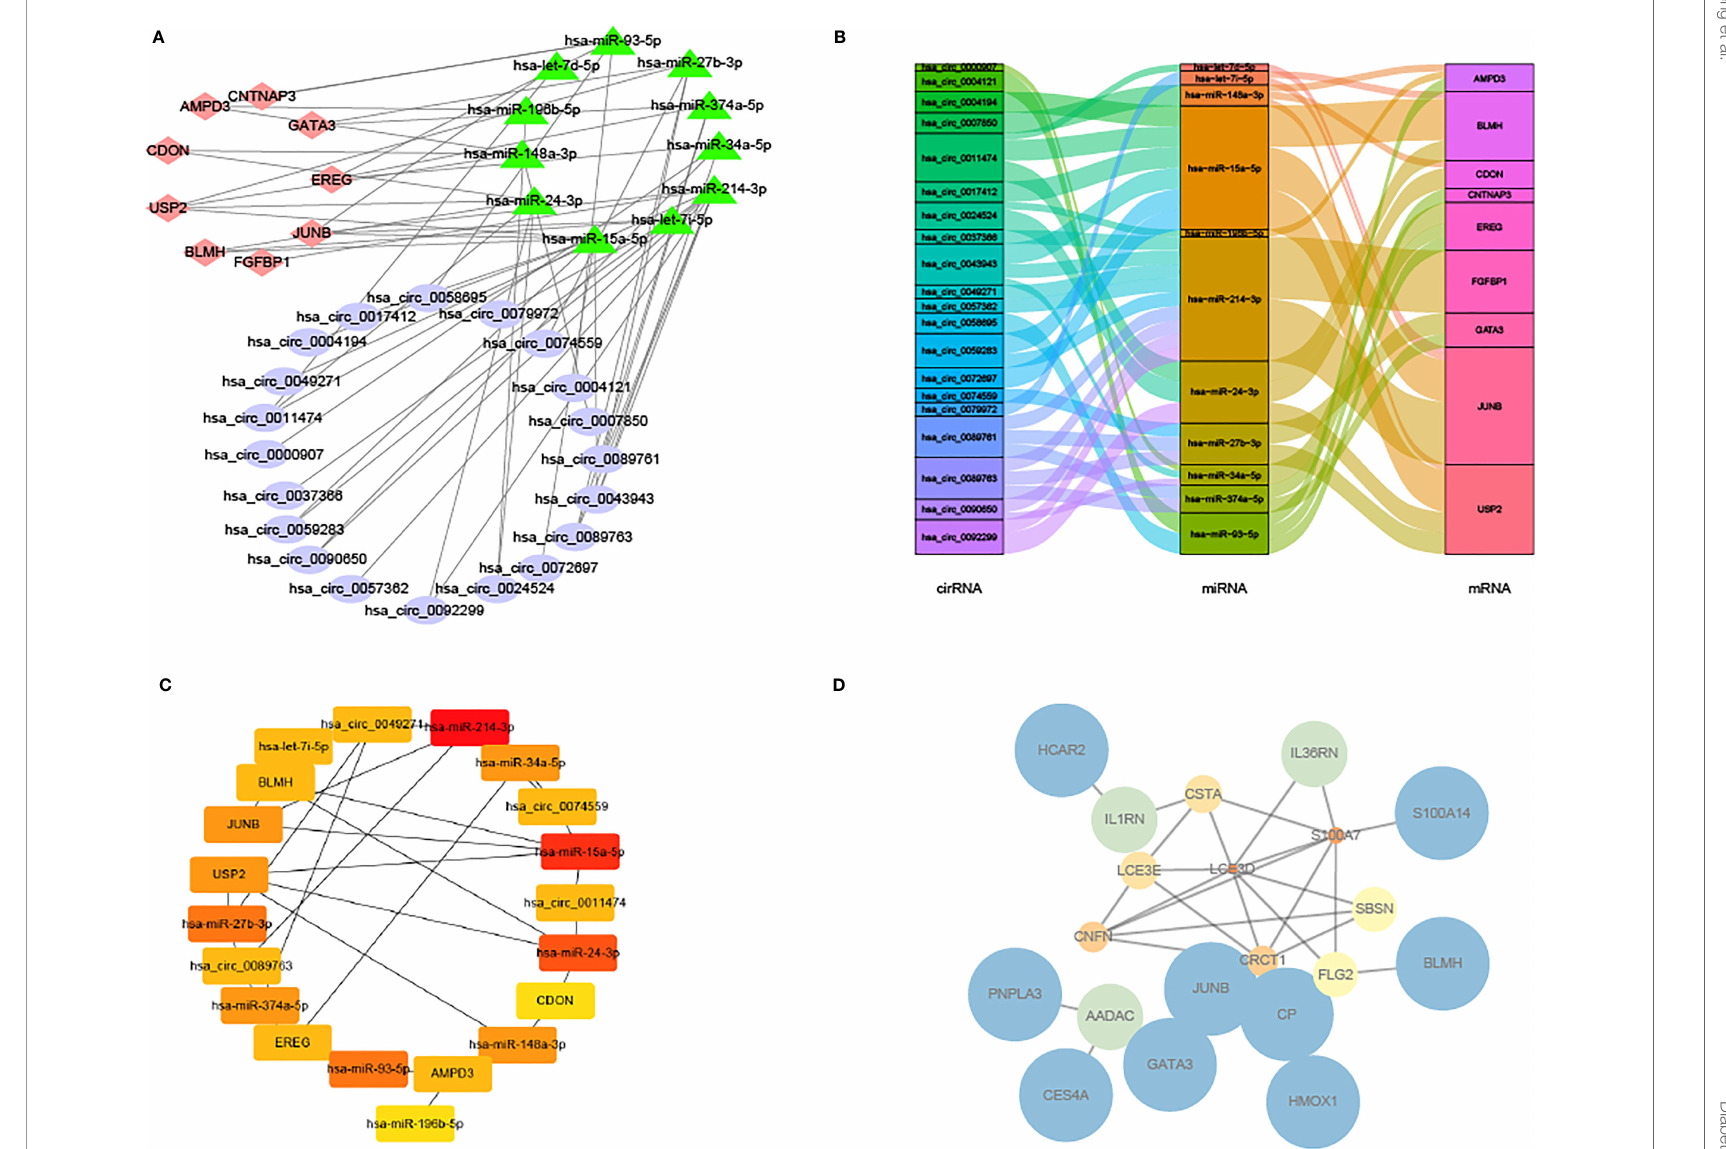
FIGURE 8 | Network and PPI network of circRNA-miRNA-mRNA. (A) Network of circRNA-miRNA-mRNA. (B) Sankey diagram of the relationship between circRNA-miRNA-mRNA. (C) Network of signi fi cant circRNA-miRNA-mRNA. (D) PPI network of DEGs in GSE80178 and